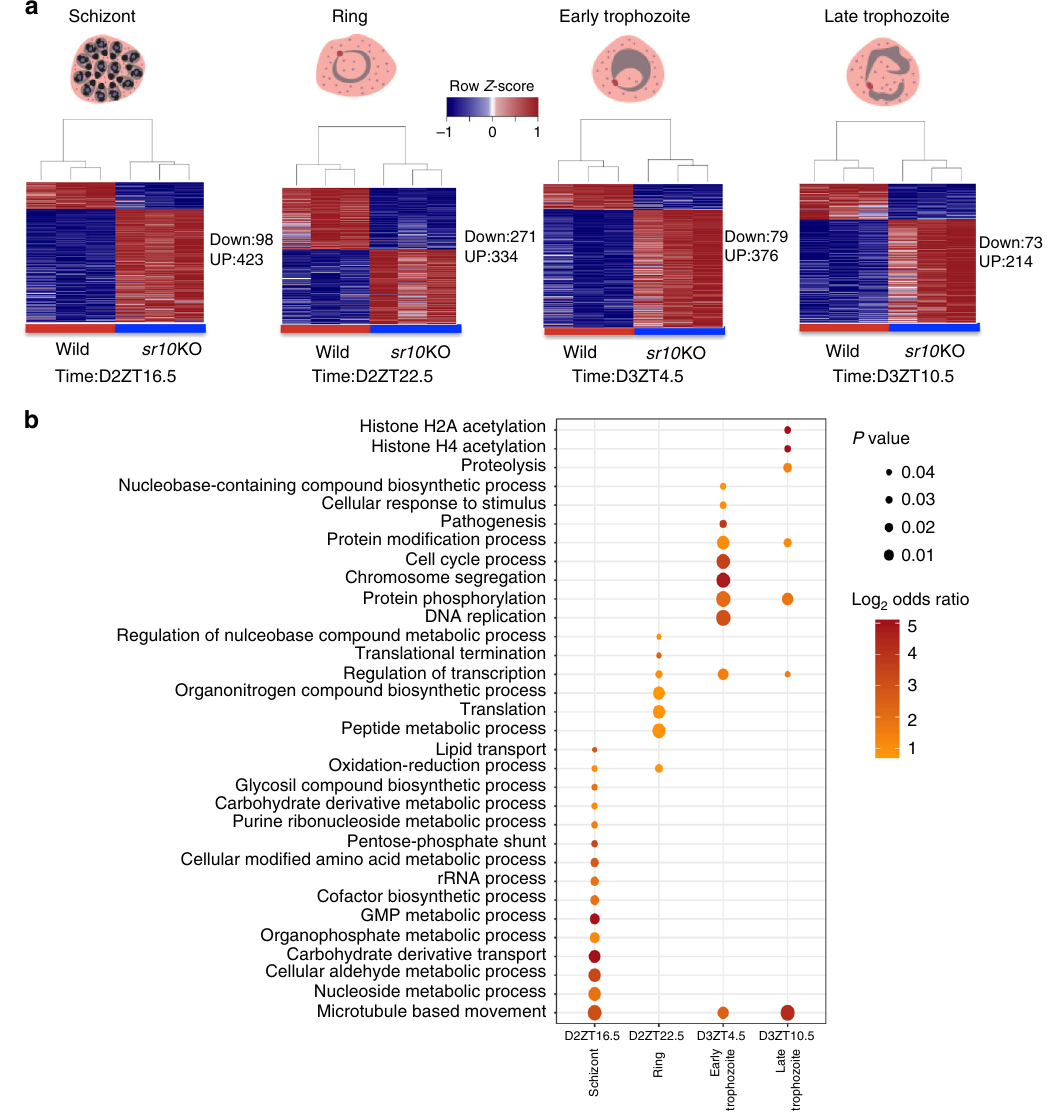
Fig. 5 Knock out of sr10 affects multiple biological processes. a Differentially regulated genes were identi fi ed by comparing four matching time points of sr10 KO and wild type Plasmodium chabaudi parasites. Up and down represent differentially regulated genes with the false discovery rate corrected p < 0.05 and Log 2 fold change < − 1 for downregulated genes and > 1 for upregulated genes at each time point. The four time points analyzed represent four IDC stages as derived from examination of parasite morphology in thin blood smears. b Gene ontology analysis of the differentially regulated genes within each time point. Manually curated functional annotations of biological processes (False discovery rate corrected p < 0.05, hypergeometric test, one-sided) are represented and the color spectrum represents the odds